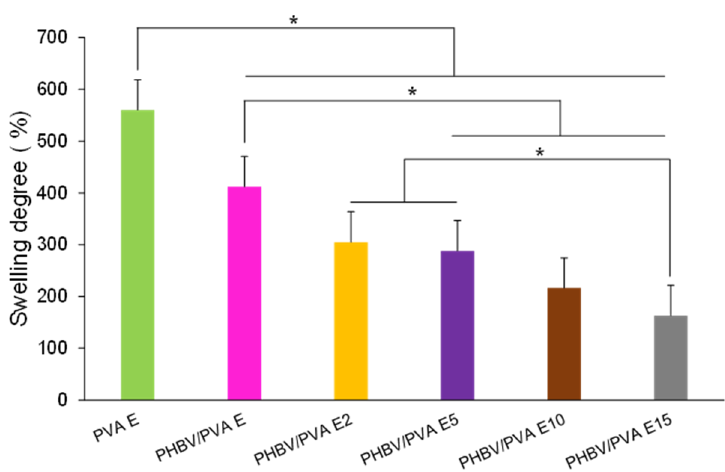
Figure 5. Swelling degree in equilibrium for PHBV/PVA E with different percentages of PPy nanoparticles ranging from 0 to 15 wt/wt %. PVA E is included as reference. Statistically significant differences ( p < 0.05) are represented as (*).